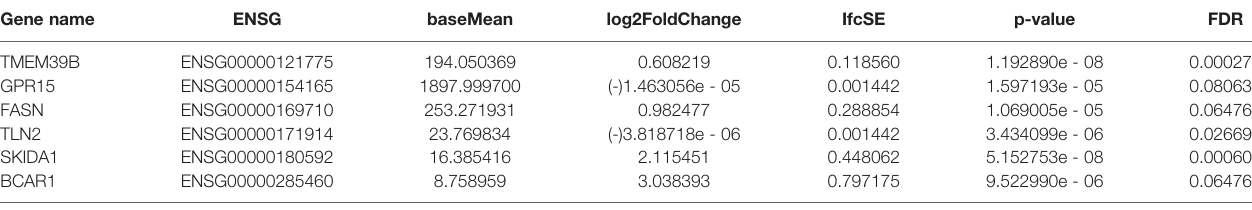
TABLE 2A | Gene expression signi fi cantly up or down-regulated in APS-1 patients ’ Tregs ’ compared with healthy subjects (Adjusted p<0.1).